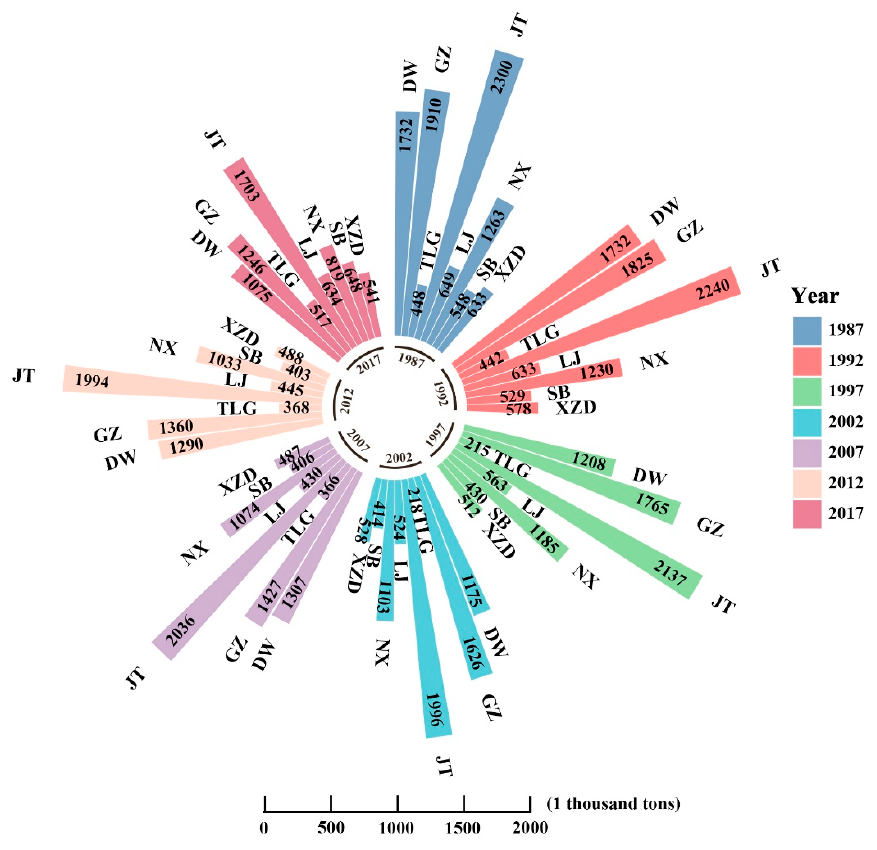
Figure 4. AGB of each town from 1987 to 2017. DW, GZ, TLG, JT, LJ, NX, SB, XZD are short for Dongwang, Geza, Tiger Leaping Gorge, Jiantang, Luoji, Nixi, Sanba, Xiao Zhongdian, respectively.